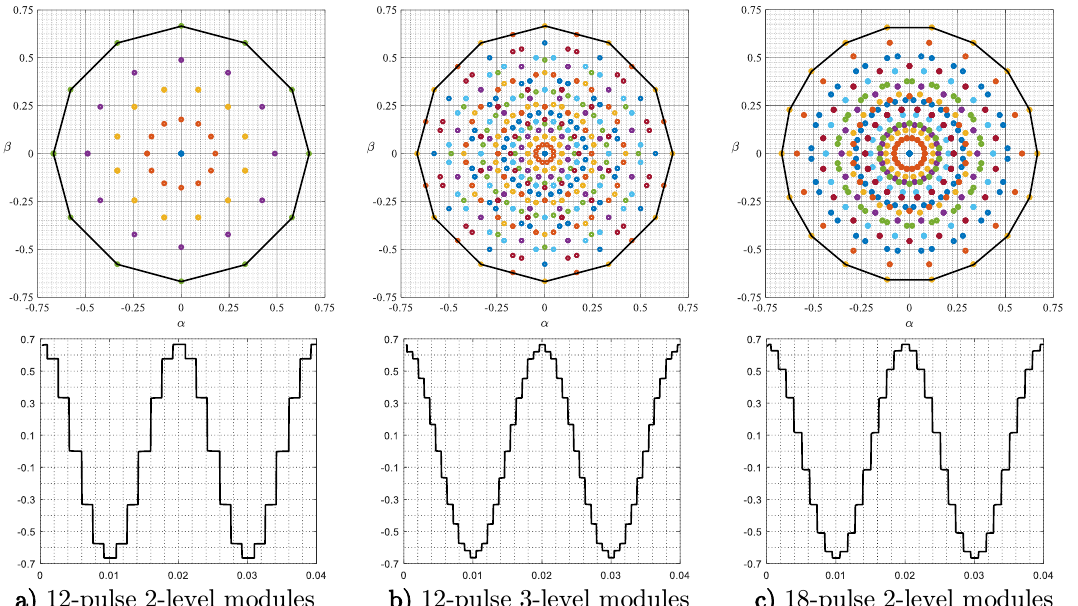
Figure 5. Space-vector diagrams of three modular VSI topologies (top graphs) and example voltage waveforms (bottom graphs) corresponding to the sequences of vectors indicated by connecting lines: ( a ) 12-pulse 2-level modules; ( b ) 12-pulse 3-level modules; ( c ) 18-pulse 2-level